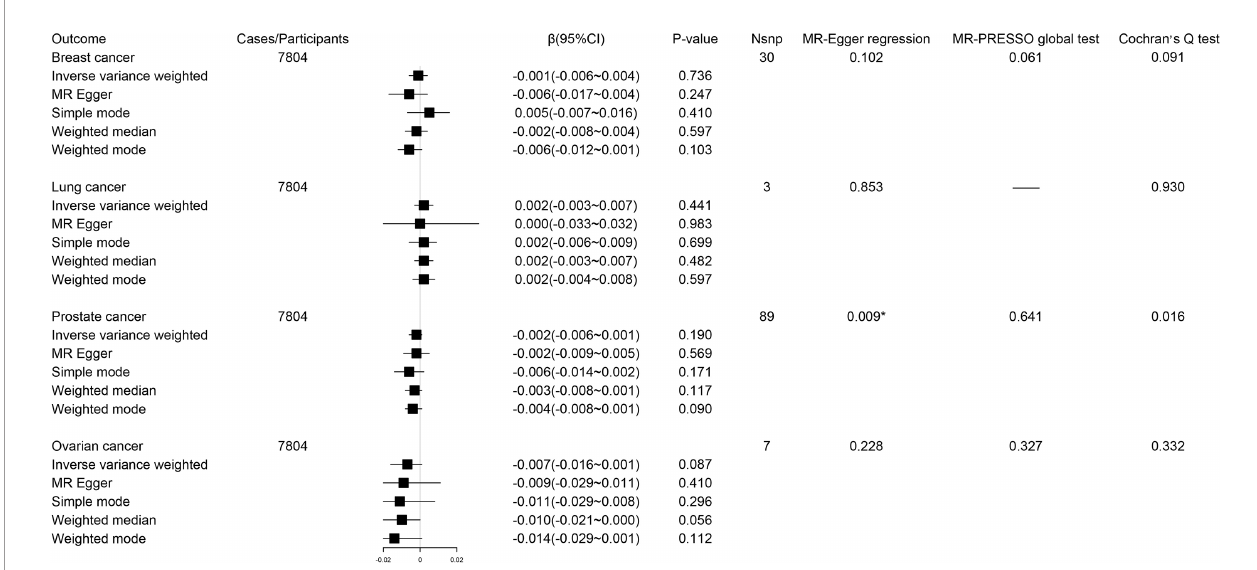
FIGURE 3 | Forest plot for associations between site-speci fi c cancers and circulating tryptophan levels. b , beta value; CI, con fi dence interval; Nsnp, number of the SNPs; *P <